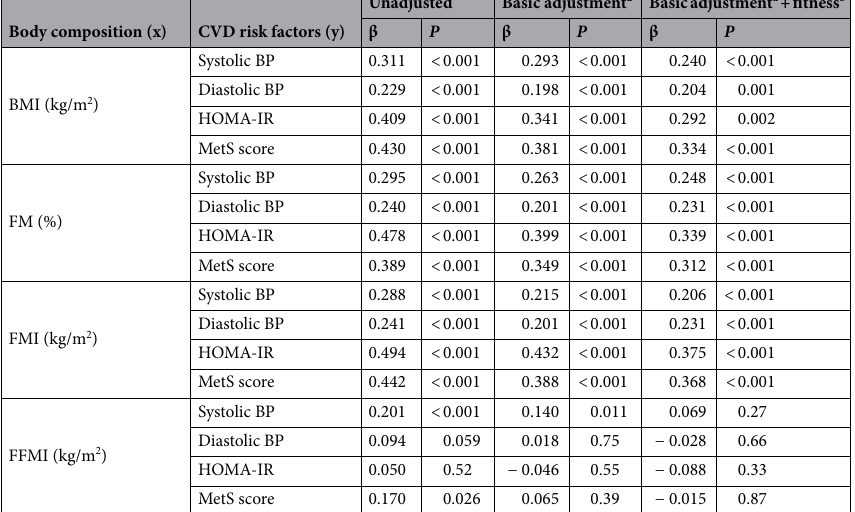
Table 3. Associations of body composition with cardiovascular risk factors in 9-year-old children. β, standardized regression coefficient; BP, blood pressure; BMI, body mass index; CVD risk factors, cardiovascular disease risk factors; FFMI, fat-free mass index; FM, fat mass; FMI, fat-mass index; HOMA-IR, Homeostatic Model Assessment of Insulin Resistance; MetS score, metabolic syndrome score. a Adjusted for child’s age and sex, maternal educational level and maternal BMI (for models with FMI and FFMI as independent variables, the models were also mutually adjusted for FMI and FFMI). b Additionally adjusted for cardiorespiratory fitness (20 m shuttle run) and handgrip